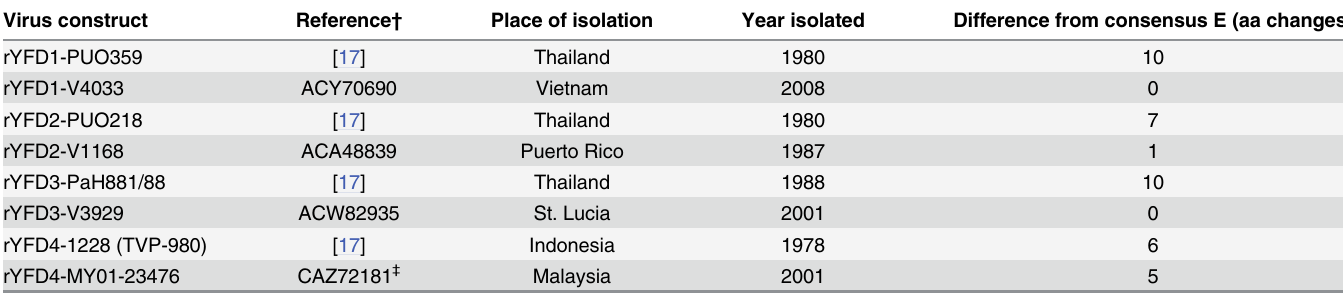
Table 1. Recombinant chimeric Yellow fever dengue